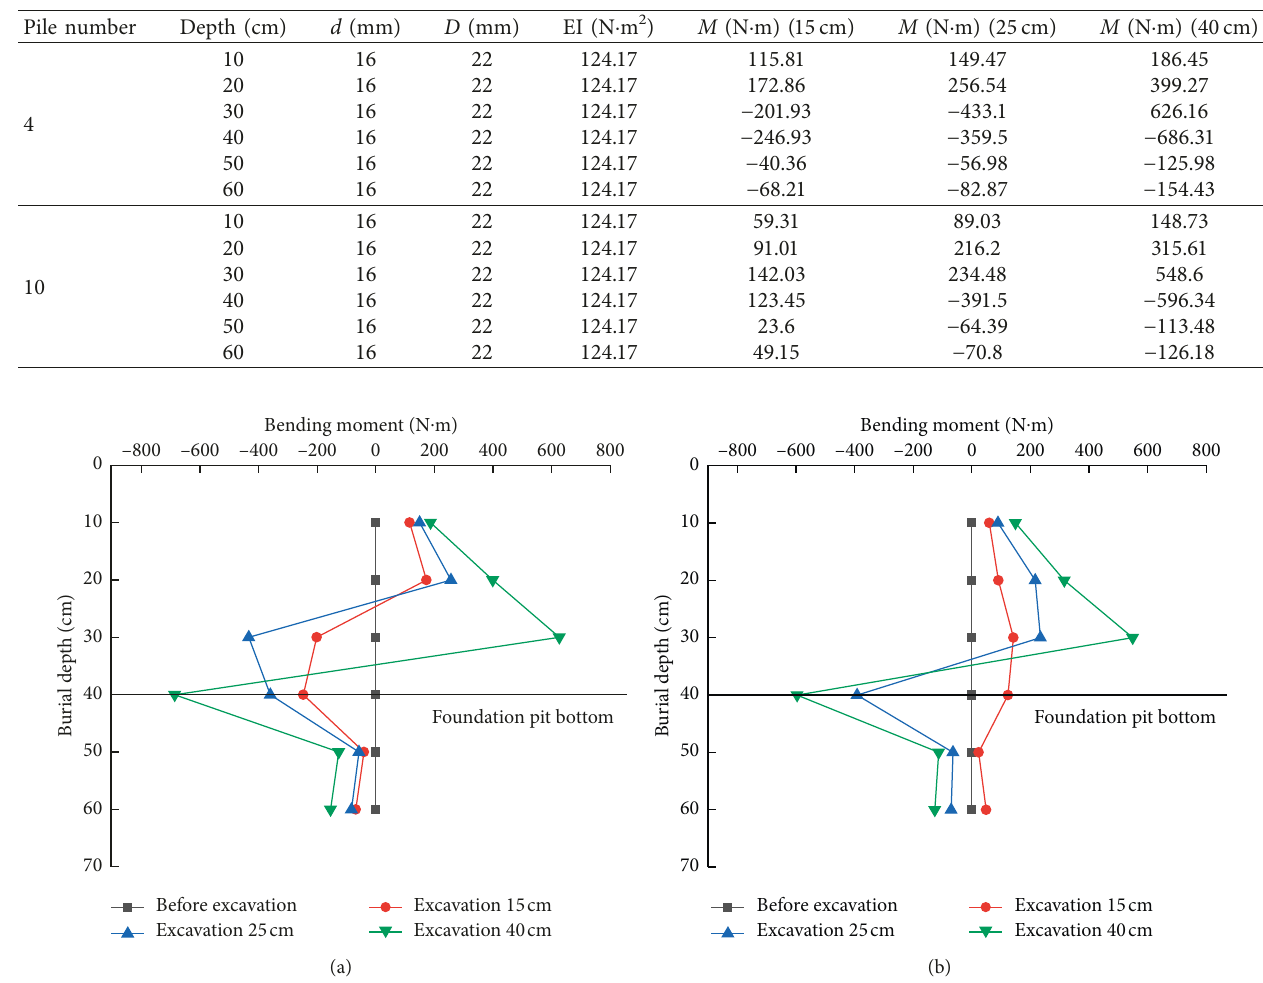
Figure 10: Earth pressure distribution curves behind piles in the loading stage. (a) Earth pressure of pile 4. (b) Earth pressure of pile 11. Table 4: Calculation of pile bending moment.